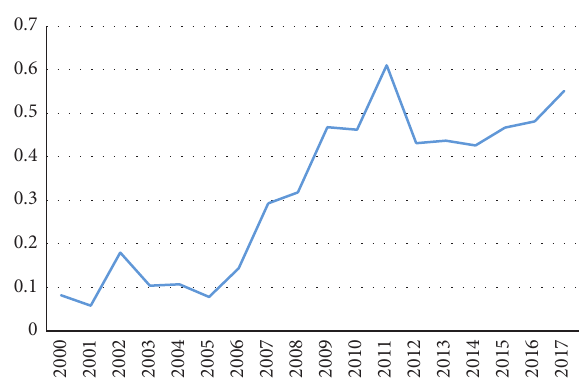
Figure 4: Agglomeration coefficient evolution of China’s non- ferrous metal collaborative innovation network.